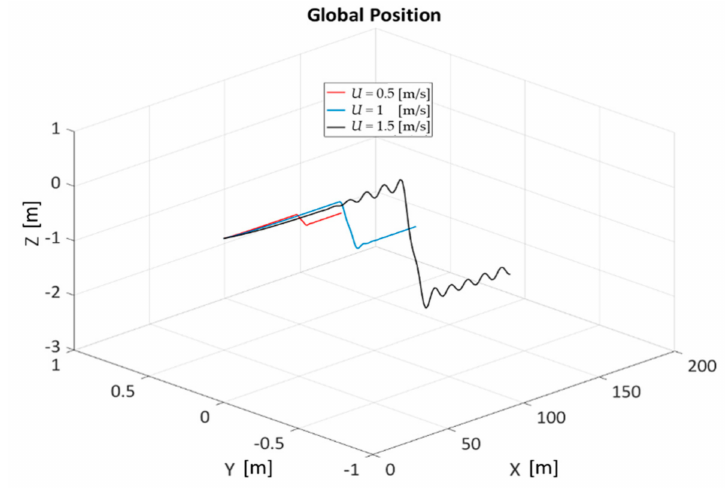
Figure 21. The SFRM’s trajectories in the meander test at different sailing speeds.